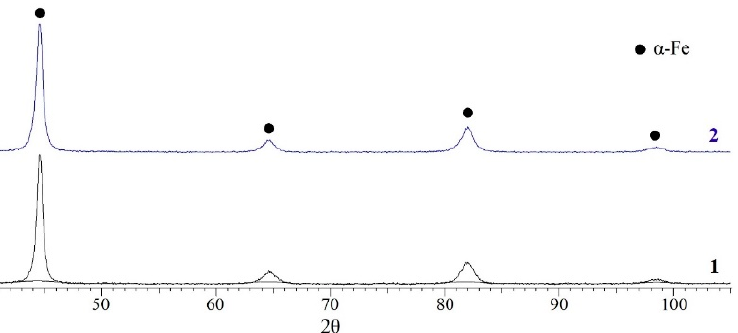
Figure 8. XRD of L-DED samples in the perpendicular ( 1 ) and longitudinal ( 2 ) directions with US-assisted treatment. Table 2. XRD Rietveld results showing the structural parameters.